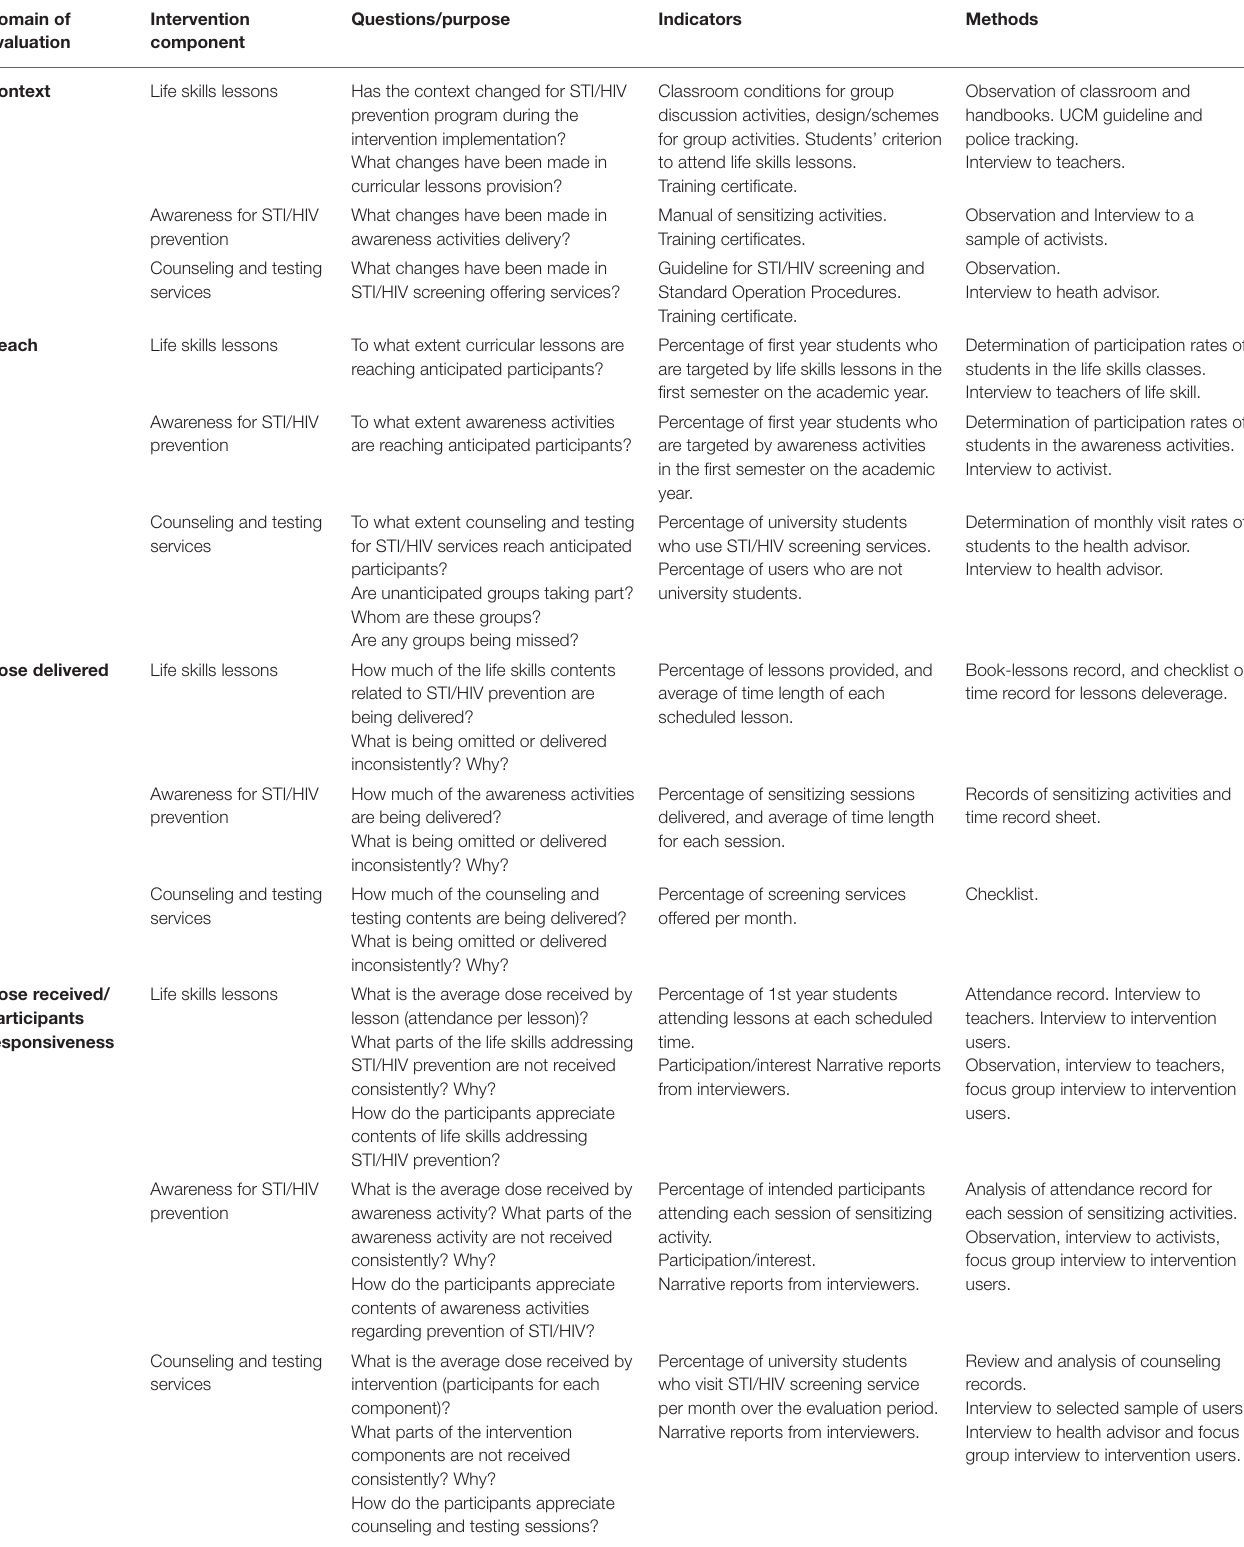
TABLE 1 | Process evaluation overview for the “Take the opportunity to listen and to be listened to!” Domain of